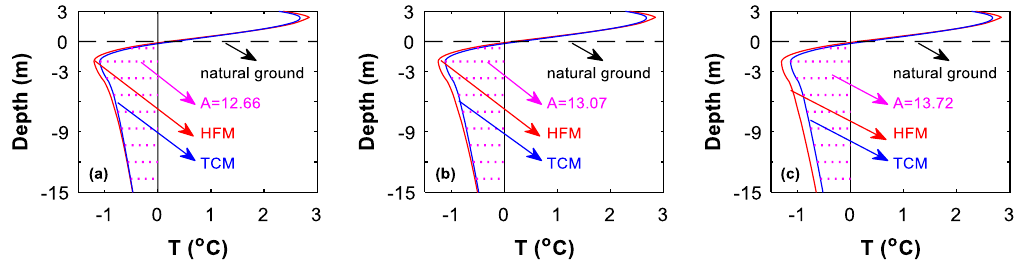
Figure 7. The central-borehole temperature profile predicted by HFM is compared with that by TCM. Date: on October 27. ( a ) 5th year, ( b ) 10th year, and ( c ) 50th year.